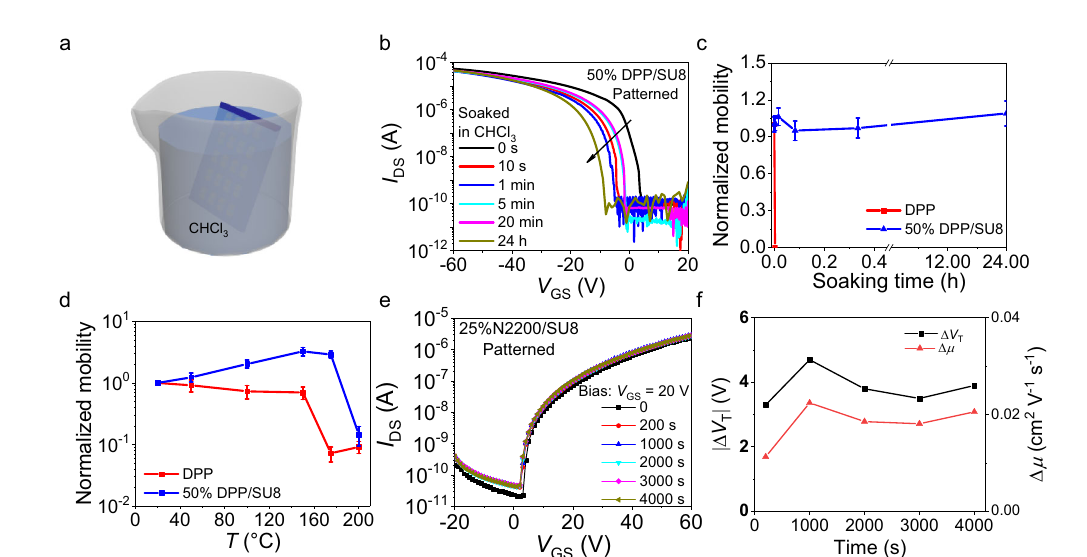
Fig. 4 Chemical and thermal stability of DPP and 50% DPP/SU8 devices. a Schematic of device soaking in CHCl 3 . b Transfer curves and c normalized mobility of DPP and patterned 50% DPP/SU8 devices after CHCl 3 immersion for various times. The V DS is − 60 V. The error bars are the standard deviation. d Normalized mobilities of DPP and 50% DPP/SU8 devices evaluated at various temperatures. The error bars are the standard deviation. e Transfer curves evolution of patterned 25%N2200/SU8 OTFTs under positive gate bias stress at a V GS of 20 V for up to 4000 s. The V DS is 60 V. f Threshold voltage shift ( Δ V T ) and mobility shift ( Δ µ ) of the patterned 25%N2200/SU8 devices OTFTs under positive gate bias stress.